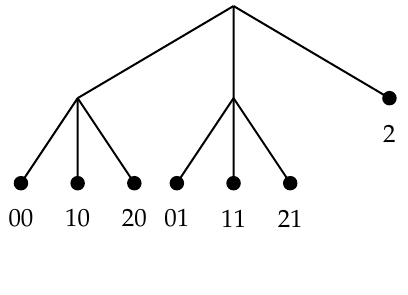
Figure 1. Graphical representation of the context tree τ .